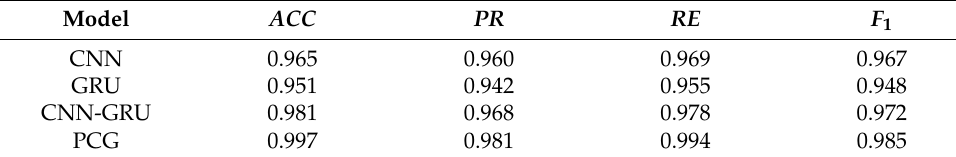
Table 7. Damage location identification results of the four